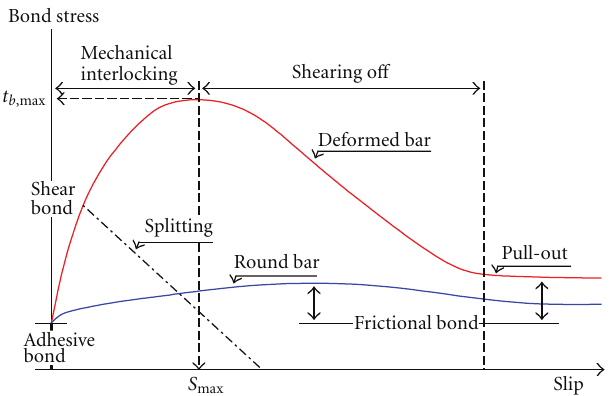
Figure 1: Bond stress-slip relationship.